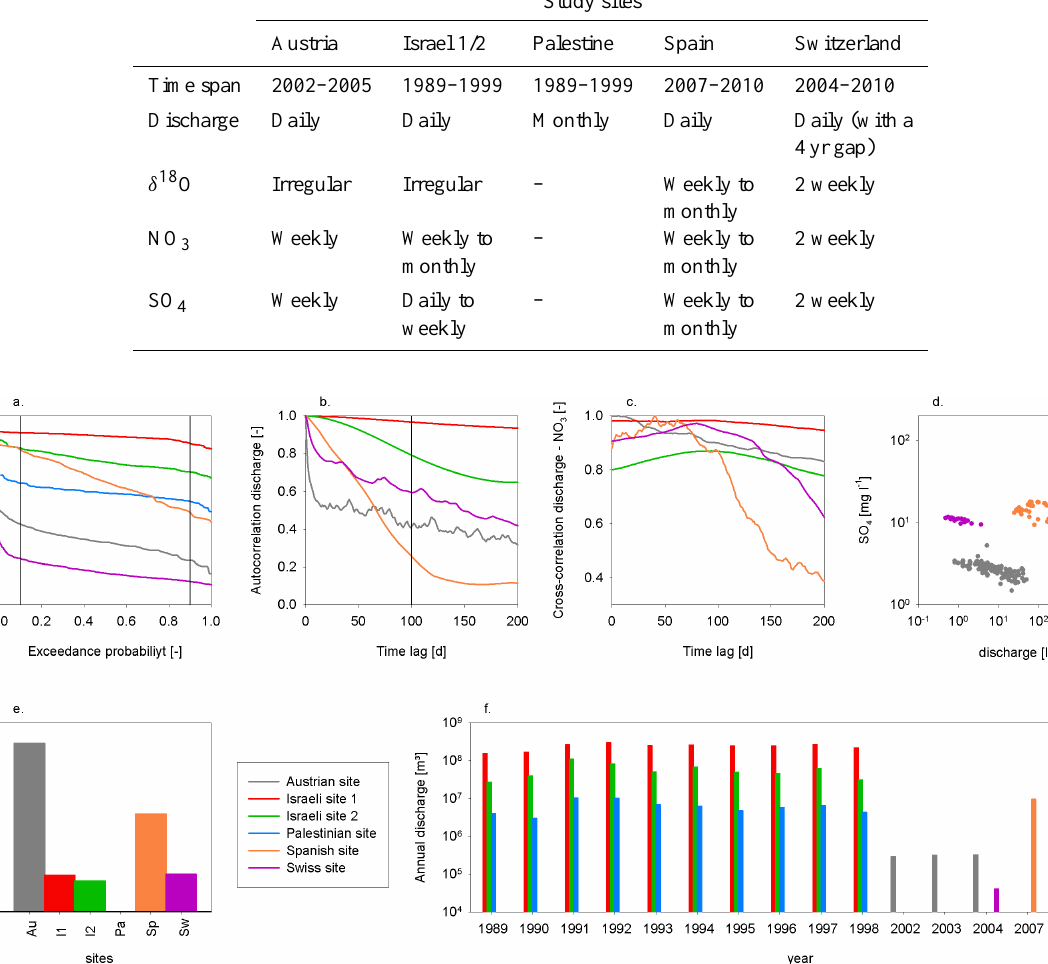
median flows (0.1 to 0.9) and low flows (0.9 to 1.0). In